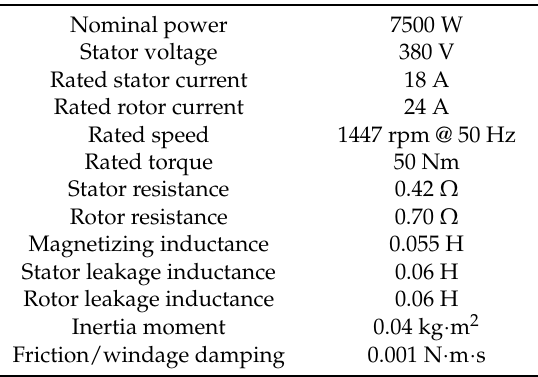
Table A3. Ratings and parameters of the